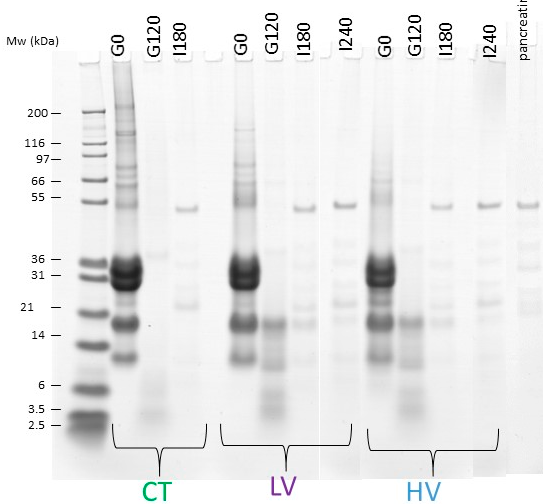
Figure 3. SDS-PAGE of the undigested 3 yogurts, i.e., control (CT), low (LV), and high (HV) viscosity before digestion (G0), after 120 min gastric digestion (G120) and 180 and/or 240 intestinal digestion (I180, I240).